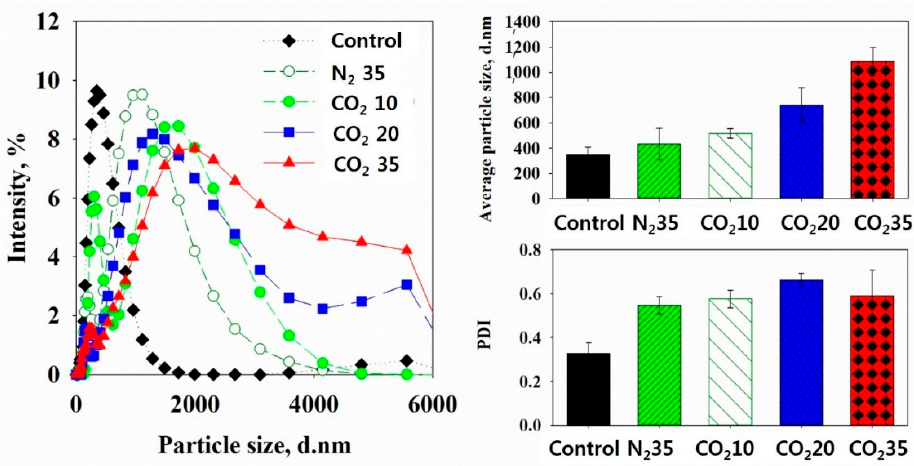
Figure 9. Particle size distribution, average particle size, and polydisperse index (PDI) in the nm